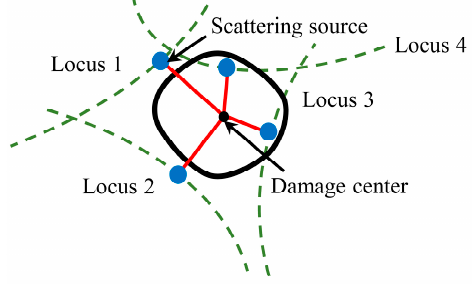
Figure 6. Scattering sources estimation.